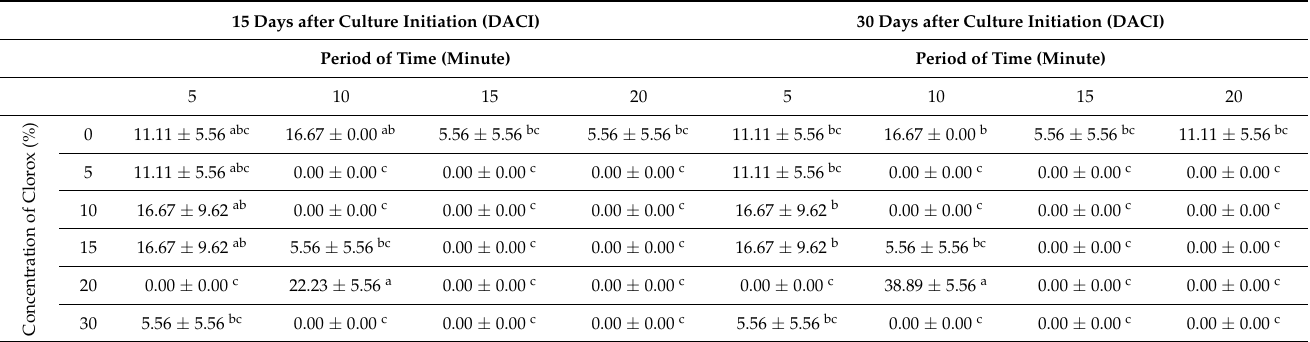
Table 5. Effect of different concentrations of Clorox used as a surface sterilizing agent for different periods of time on bacterial contamination on stevia explants (%).